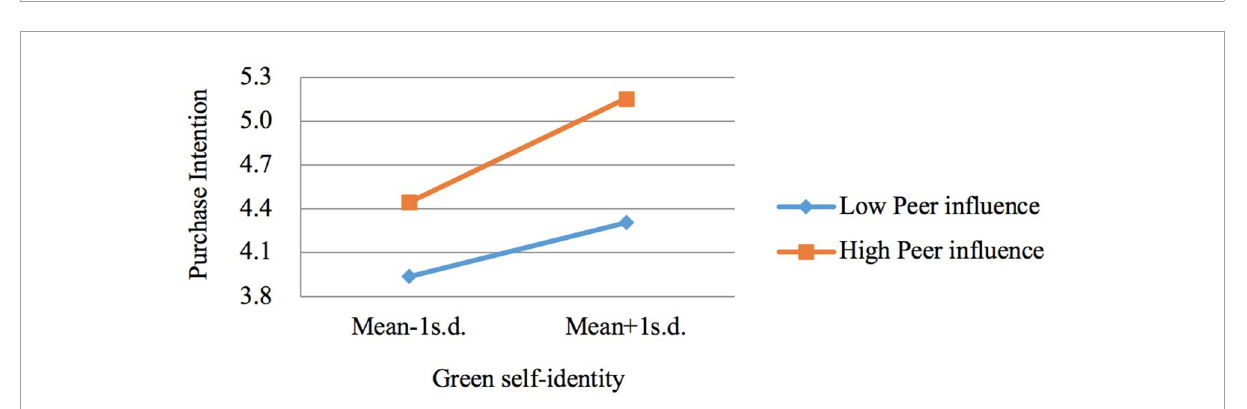
FIGURE4 The moderating effect of green peer